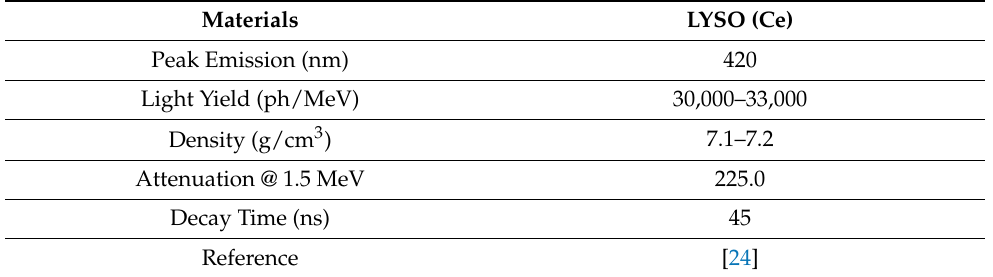
Table 1. The physical parameters of LYSO.